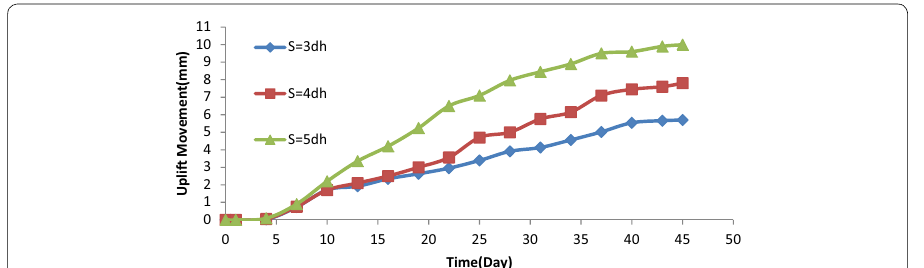
Fig. 32 Variation of uplift movement with time for pile group of L/D